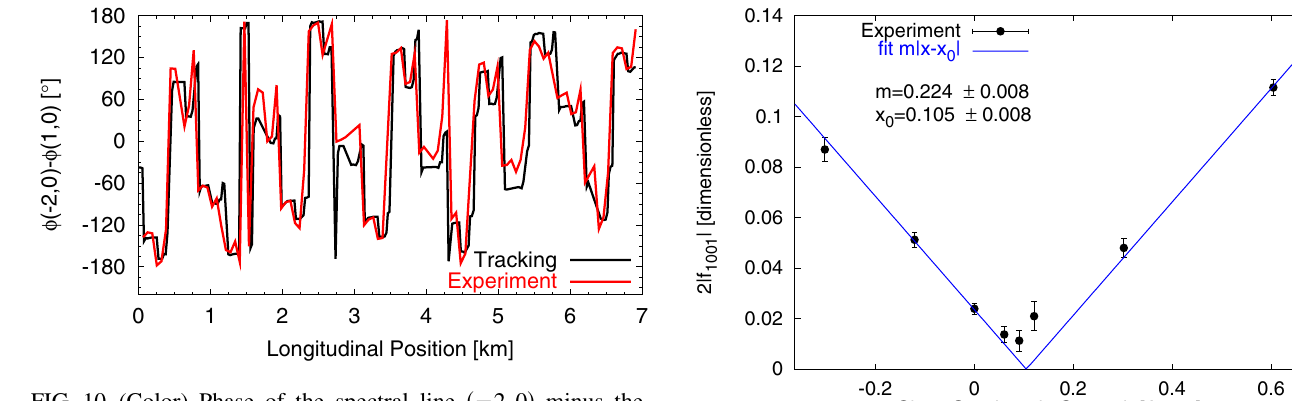
FIG. 10. (Color) Phase of the spectral line (cid:2)(cid:1) 2 ; 0 (cid:3) minus the phase of the spectral line (1,0) versus longitudinal position from experiment and tracking model for the baseline machine at 26